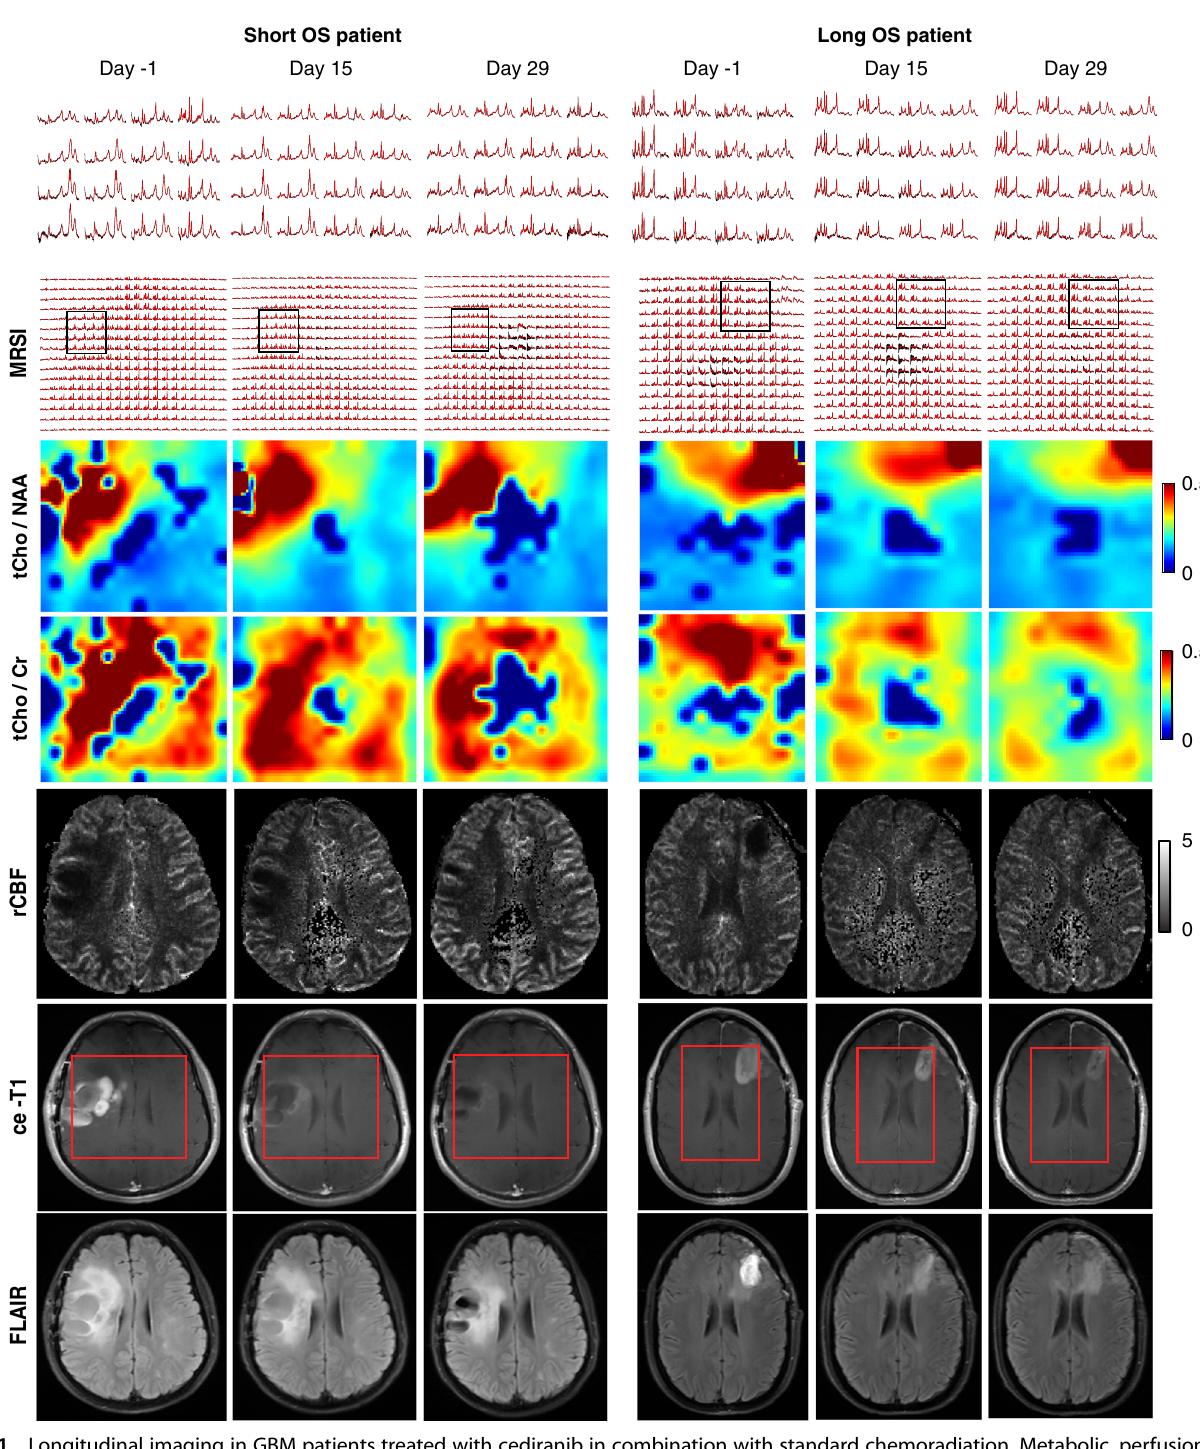
Fig. 1 Longitudinal imaging in GBM patients treated with cediranib in combination with standard chemoradiation. Metabolic, perfusion, and anatomical MR images are shown from a patient with short OS ( left ) and long OS ( right ). The short OS patient is representative for PdR with rapid decrease of ce-T1; however, tCho/hCr and tCho/NAA remain elevated. In long OS patient, the decrease of ce-T1 is accompanied by decrease of tCho/hCr and tCho/NAA. Spectra from a region inside tumor are shown on the upper row . The red rectangle overlaid on ce-T1 images indicates the VOI covered by the MRSI